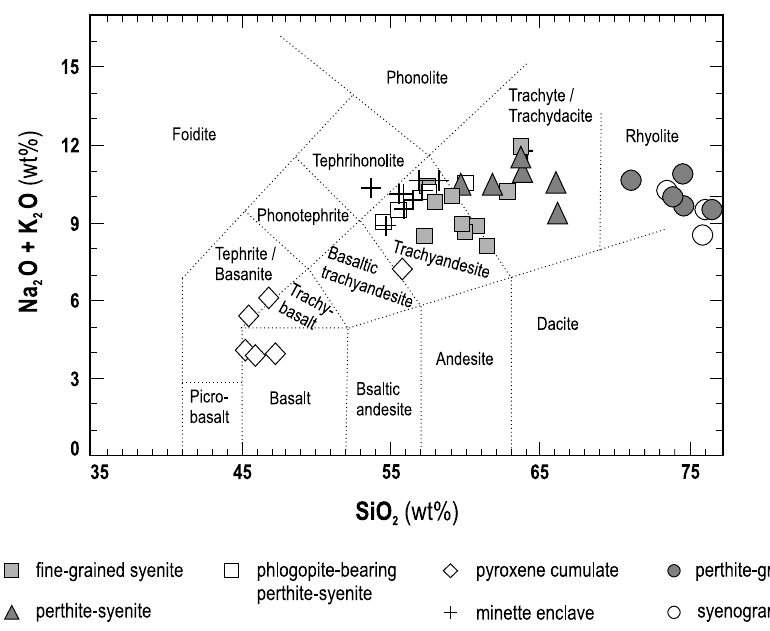
Fig. 5 – Samples from Piquiri Syenite Massif in the TAS diagram, plotting in the field of alkaline silica-saturated